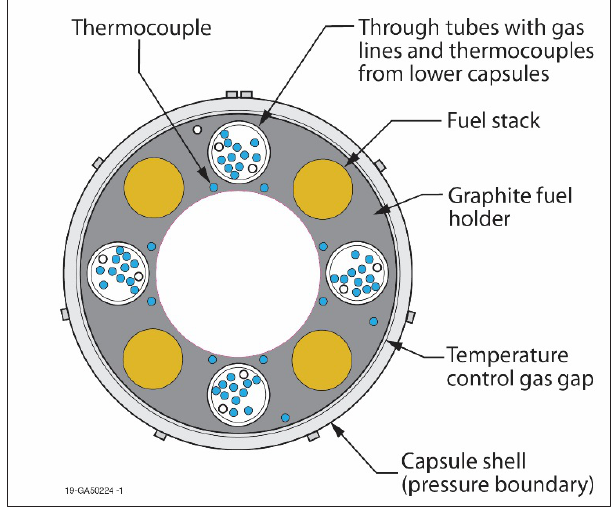
Fig. 2. Cross-section view of AGR-5/6/7 fuel experiment (capsules 2, 4,